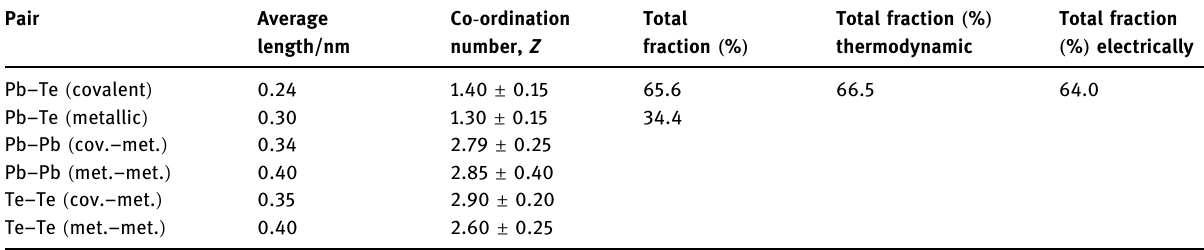
Table 2: Partial co - ordination numbers in liquid Pb 0.5 Te 0.5 by three dimensional RMC Pair